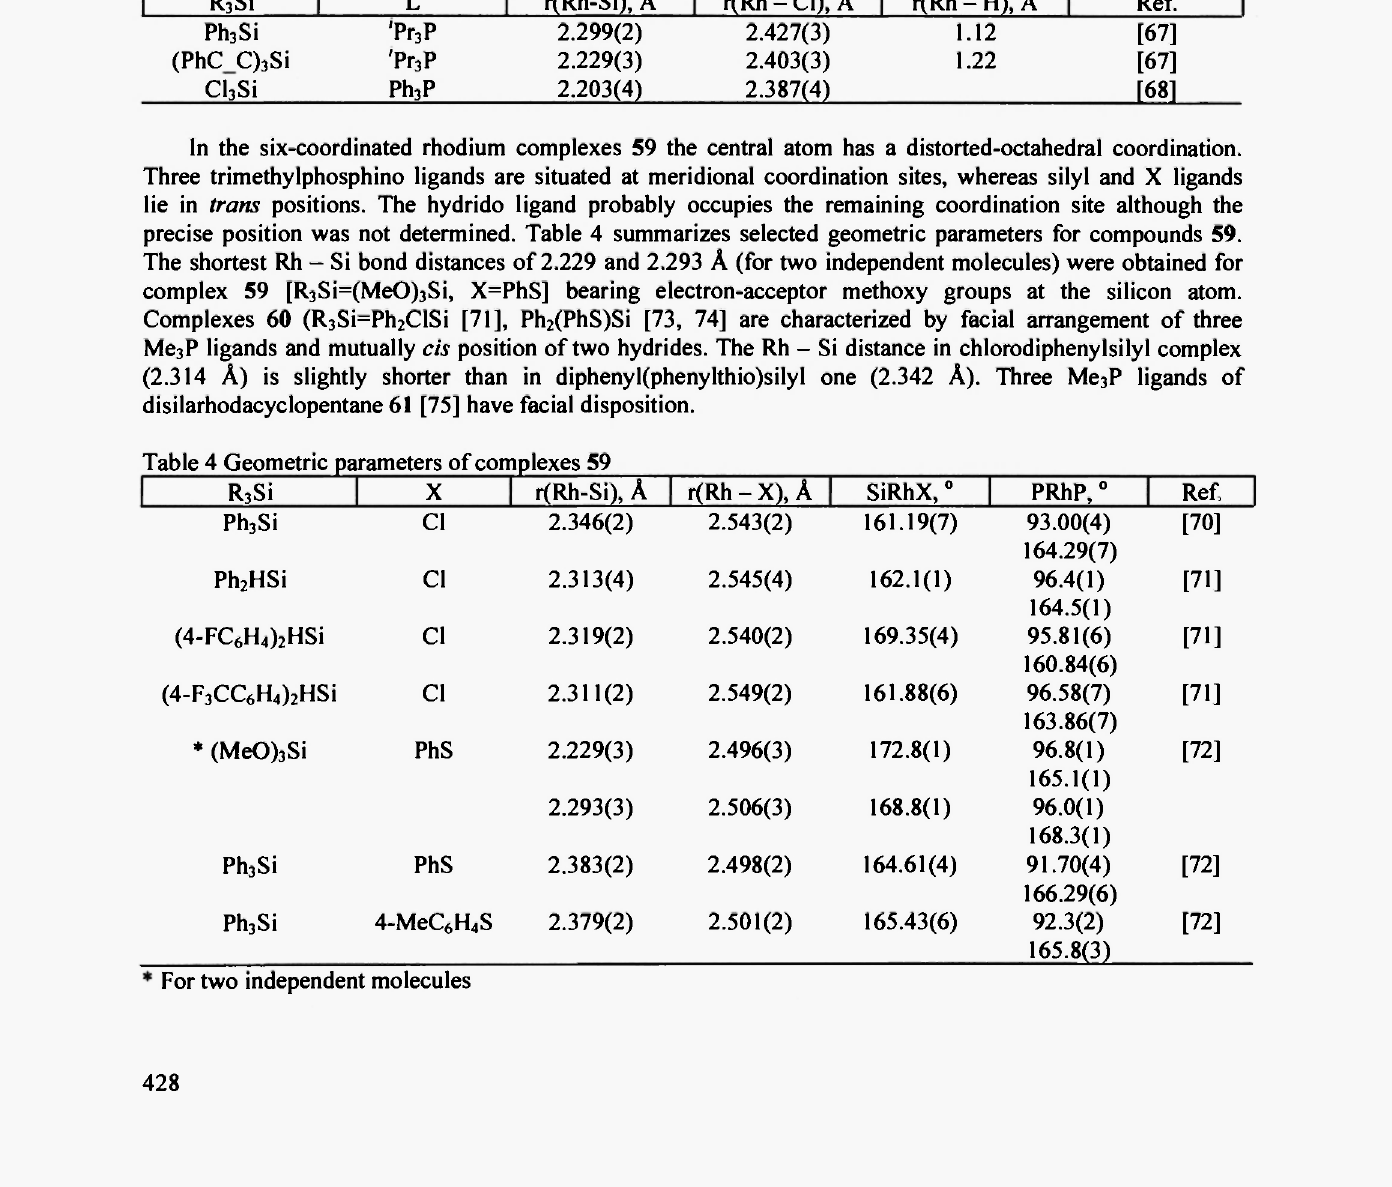
Table 3. Geometric parameters of complexes 57